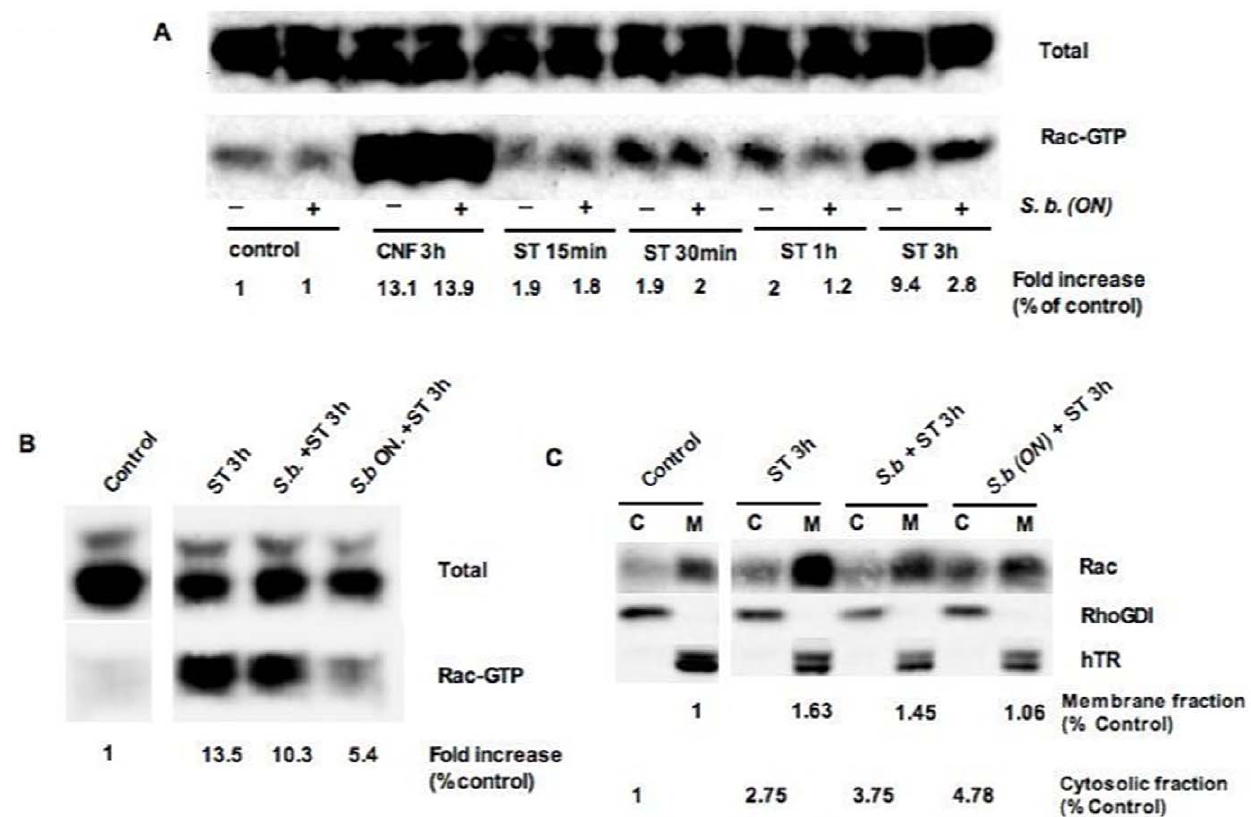
Figure 7. S.boulardii prevents Rho-GTPase Rac1 signaling pathway in HeLa cells. (A) Activation of Rac1 in cells infected for various time with S. Typhimurium (ST) strain SL1344 in the presence or absence of S. boulardii (Sb) (representative of five independent experiments). (B) Activation of Rac1 in cells infected for 3 h by ST alone or ST and Sb added at the same time and in cells exposed overnight to Sb prior infection (representative of two independent experiments). At indicated time, cells were lysed and GTP-bound Rac1 were precipitated from lysates by incubation with GST- PAK, resolved by SDS-PAGE and analyzed by immunoblotting using anti-Rac1 antibody. The control lane contained uninfected cells. CNF1 is a toxin produced by uropathogenic E. coli that activate Rac1 [34] and it is used in this study as a positive control. (C) Immunoblots showing the distribution of Rac proteins between membrane (M) and cytosolic (C) fractions in HeLa cells infected with ST for 3 h alone or in the presence of Sb (representative of two independent experiments). Immunoblots were performed with RhaGDI as loading control for cytosolic fraction and human Transferrin Receptor (hTR) was used as loading control for membrane fraction. Densitometry was performed using Multi Gauge software.